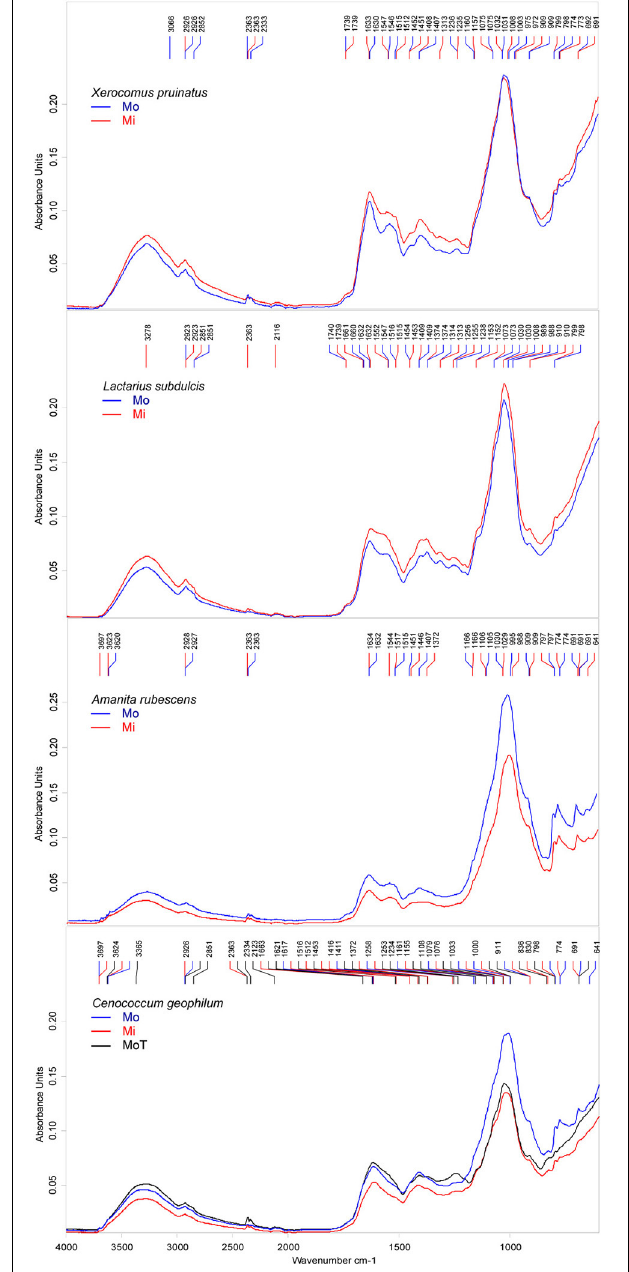
FIGURE 4 | Deconvoluted FTIR spectra of ectomycorrhizas collected in mono-specific beech (Mo) and in mixed deciduous forests (Mi) in the Hainich. Cenococcum geophilum ectomycorrhiza were collected in beech forests on the Swabian Jura (T). The peaks were automatically identified by Pick Peaking procedure (Opus software). Each spectrum represents the average of n = 10 measurements; n = 2 for Xerocomus pruinatus Mo.